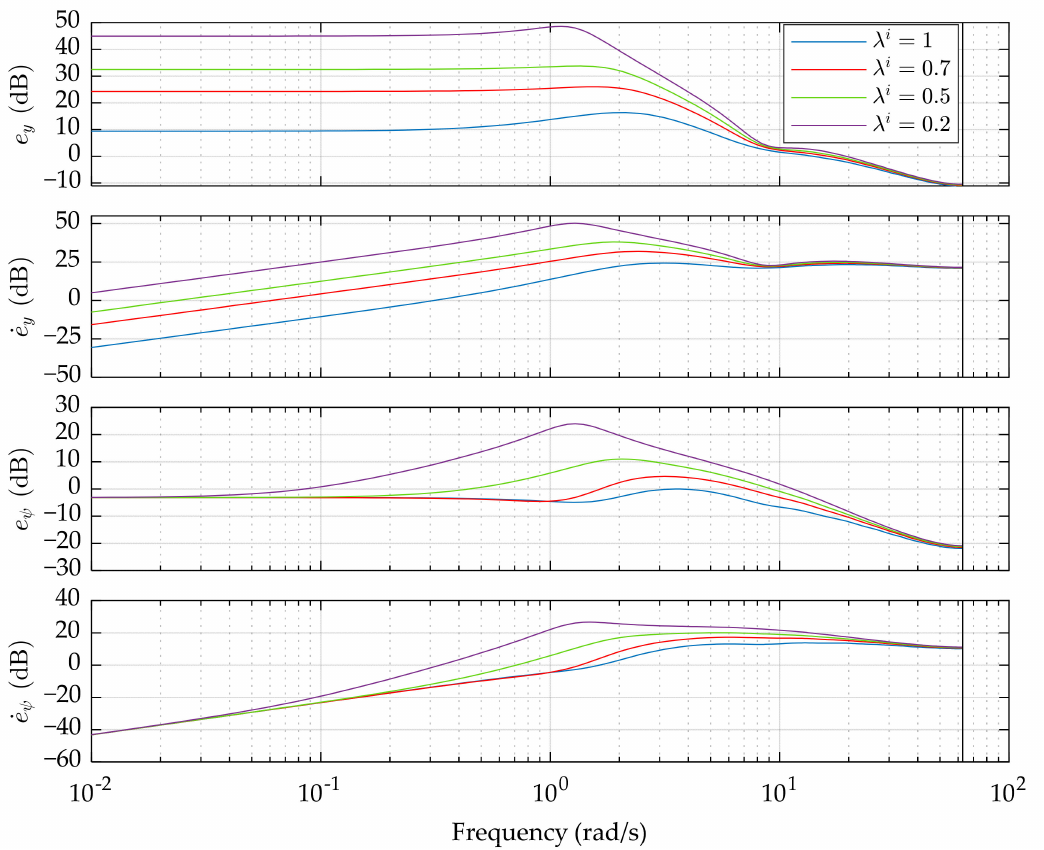
Figure 2. Path tracking performance in the frequency domain. Only the magnitude is presented. The vehicle speed is 20 m/s and the preview length is set to